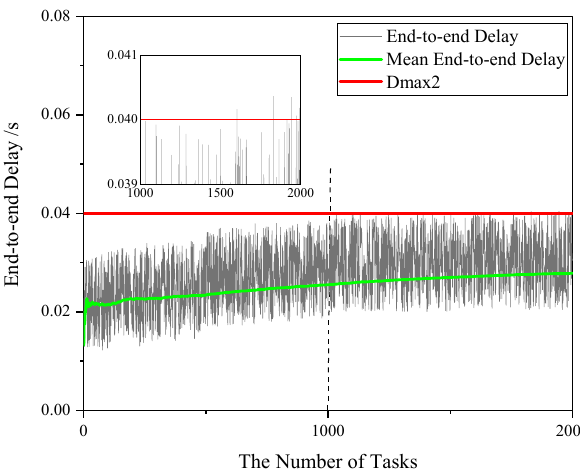
Figure 9. Converging of the end-to-end delay in a simulation.